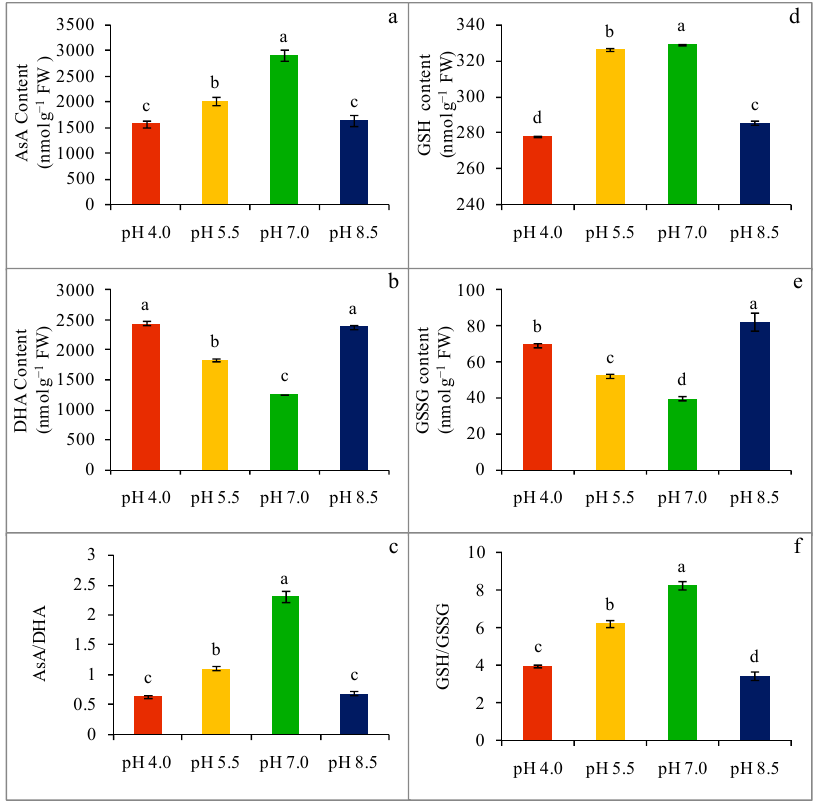
Figure 4. AsA ( a ) and DHA ( b ) contents, AsA/DHA ratio ( c ), GSH ( d ) and GSSG ( e ) contents, and GSH/GSSG ratio ( f ) of wheat leaves under different levels of pH. Mean (±SD) was computed from three replications of each treatment. Bars with dissimilar letters are significantly different at p ≤ 0.05 from Fisher’s LSD test.